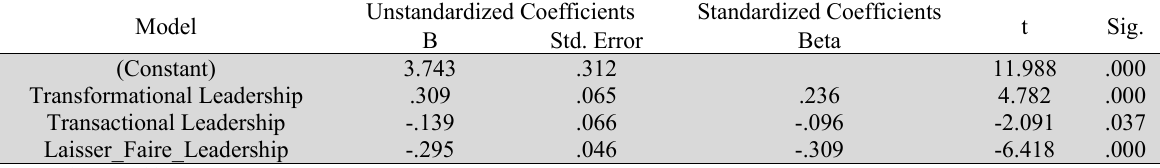
Output of Coefficients a for the Multiple Regressions